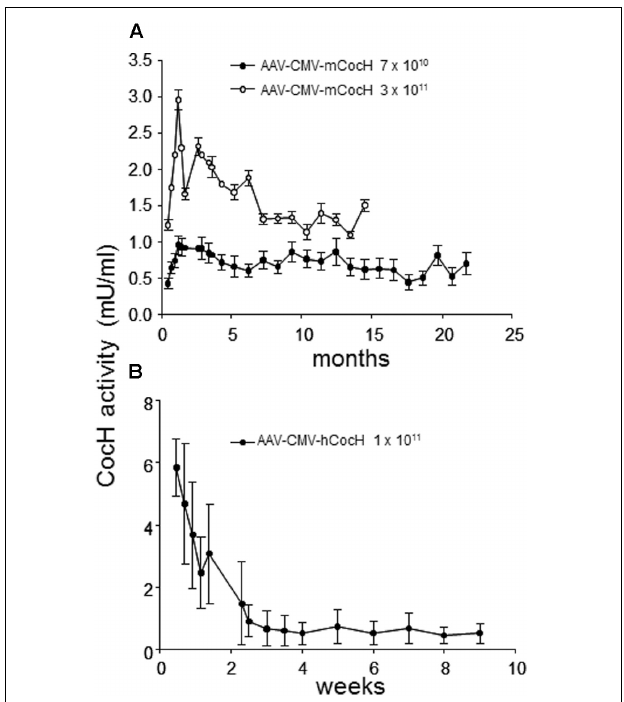
FIGURE 1 | Time course of plasma cocaine hydrolysis activities in mice receiving viral gene transfer of mouse or human BChE mutated for enhanced cocaine hydrolysis (CocH by i.v. injection of standard AAV). Data are from repeated samples of mouse plasma across time (weeks to months as noted). CocH activity was measured by enzymatic release of tritium-label isolated by solvent separation (Brimijoin et al., 2002). (A) Mice given AAV gene transfer of mouse CocH. Levels of expression were modest but were maintained for more than 1 year. (B) Mice given gene transfer of human CocH. Activities were higher, but much shorter lived (Geng et al., 2013, Figure